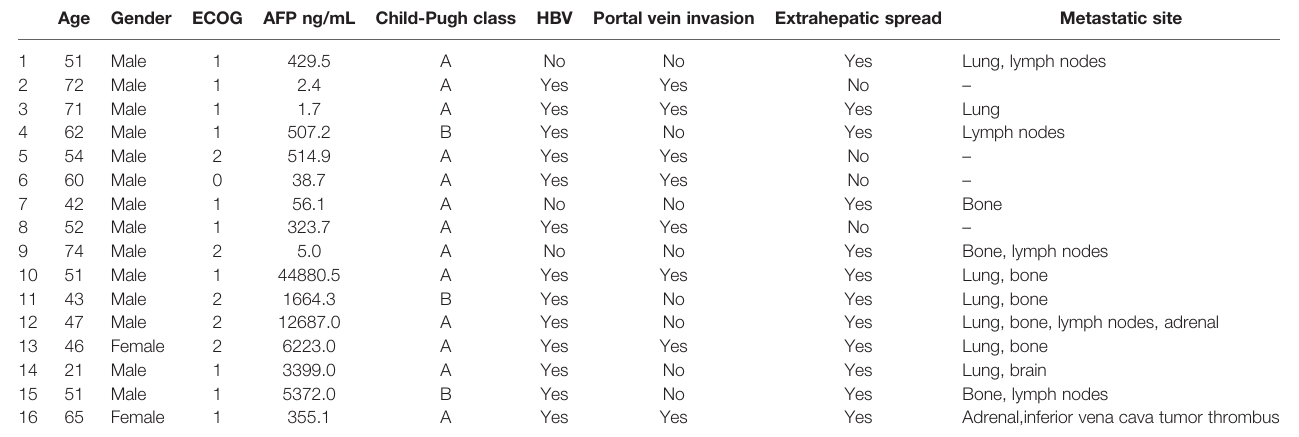
TABLE 2 | Detailed characteristics of